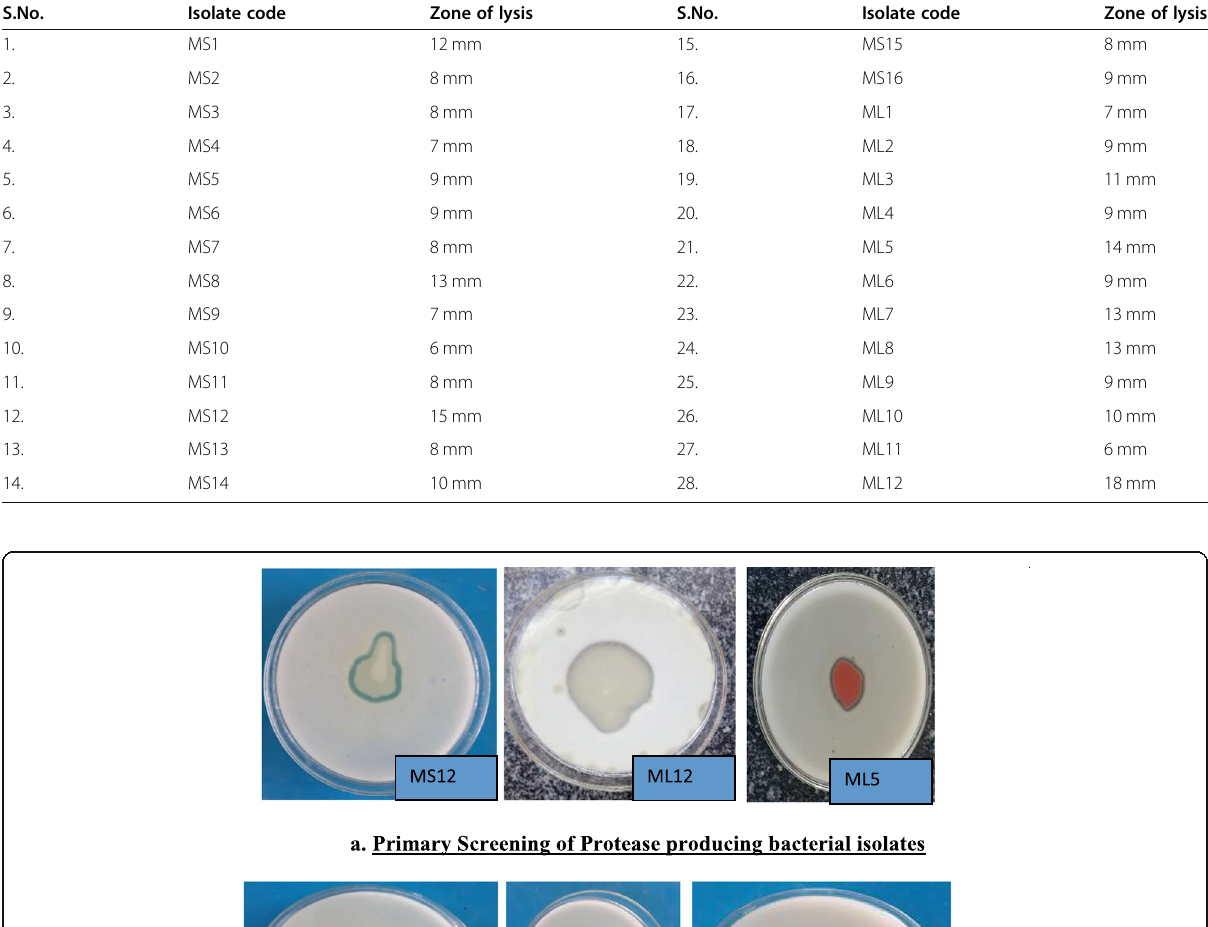
Table 1 Primary screening of protease producing bacterial isolates S.No.